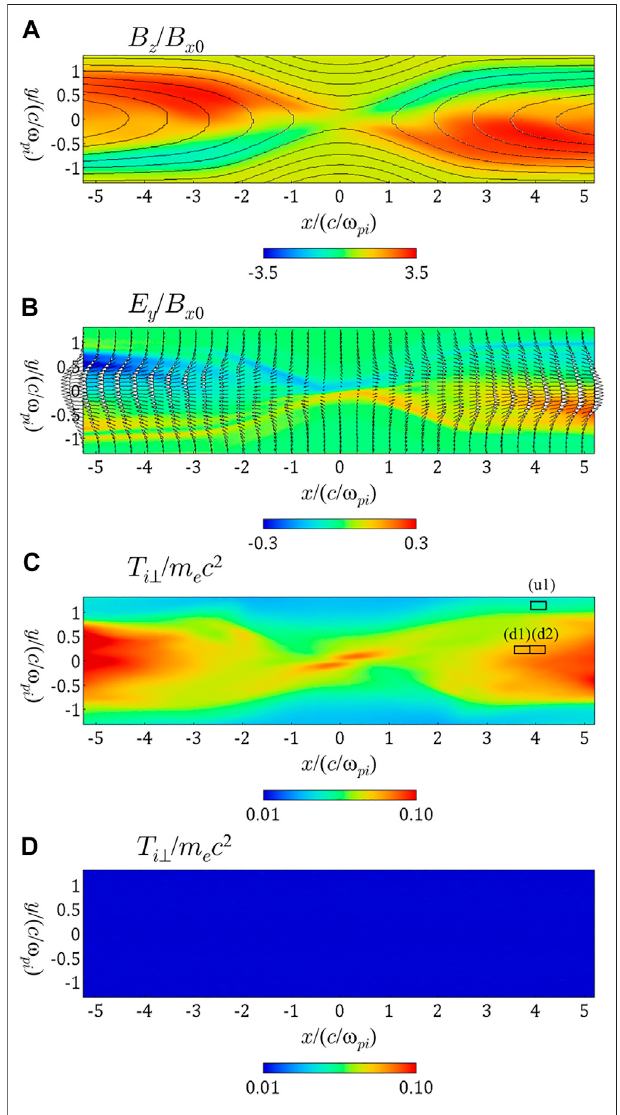
FIGURE5 | Spatial pro fi les of (A) : B z and the magnetic fi eld lines (B) : the ionbulkvelocityvectorsand E y (C) and (D) :theiontemperatureperpendicular to the magnetic fi eld. The panels (A) – (C) display results at ω pi t = 775, and the panel (D) shows a result at the initial